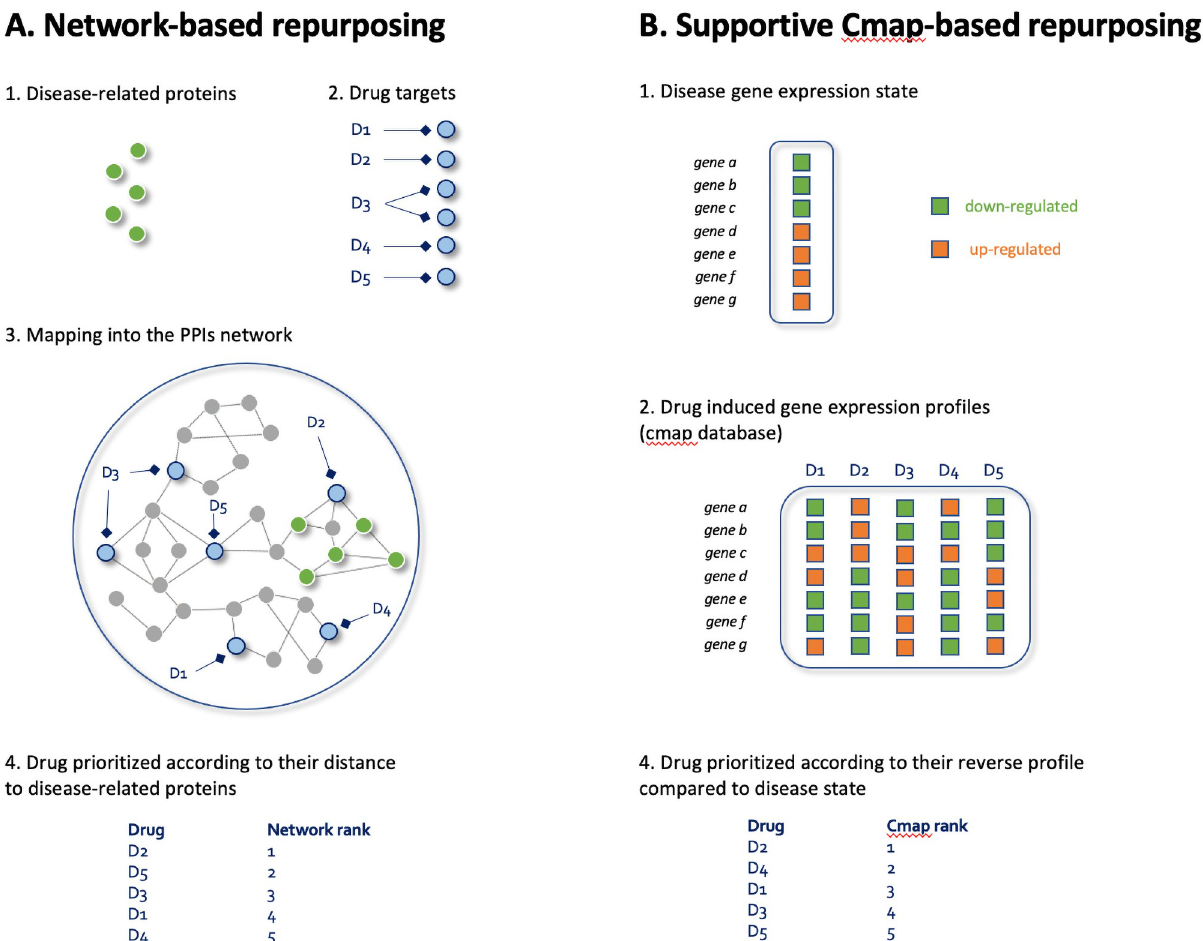
Fig 1. General principles of network and Cmap-based repurposing approaches. A) Network-based repurposing. Disease-related proteins and drug targets are mapped into a network of protein-protein-interactions (PPI). Drugs are prioritized according to their distance to disease-related proteins. B) Supportive Cmap-based repurposing. In those supportive analyses, disease-related as well as drug induced gene expression states are compared in order to identify drugs eliciting reverse profiles compared to those found in the disease.